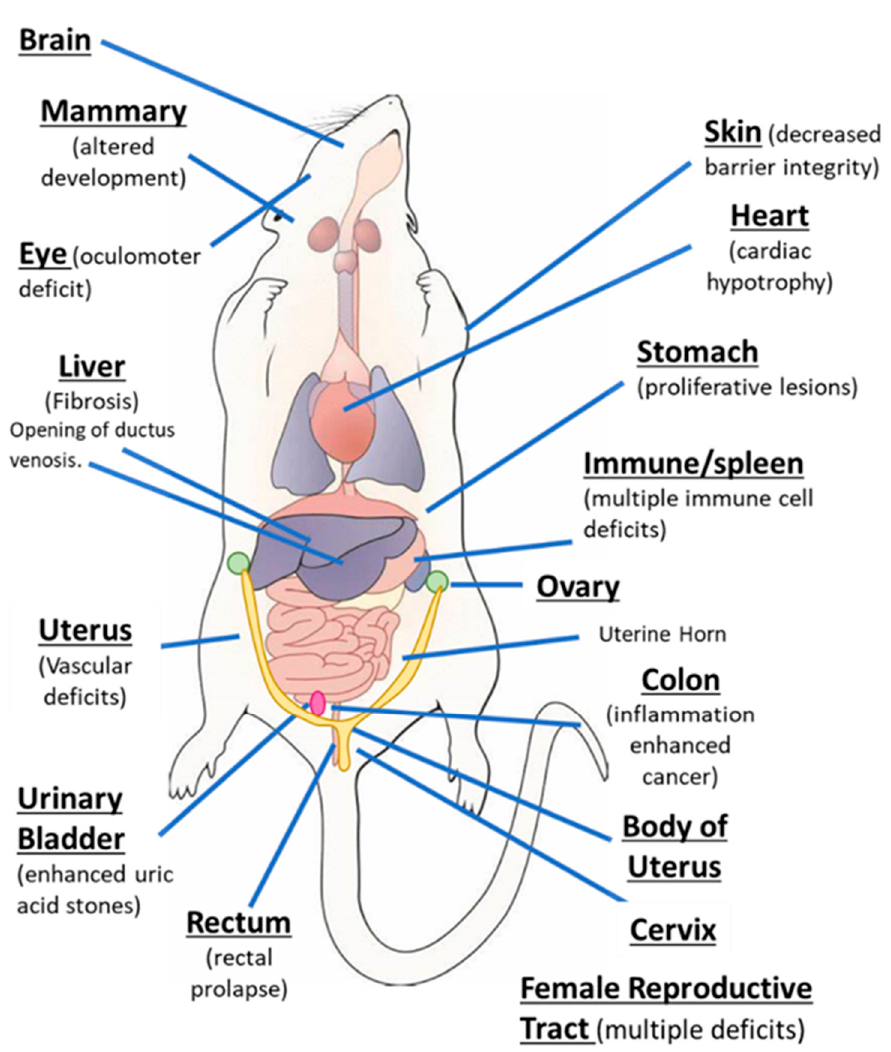
Figure 1. The aryl hydrocarbon receptor (AhR) plays a role in cellular homeostasis in several tissues/organs in the mouse models.